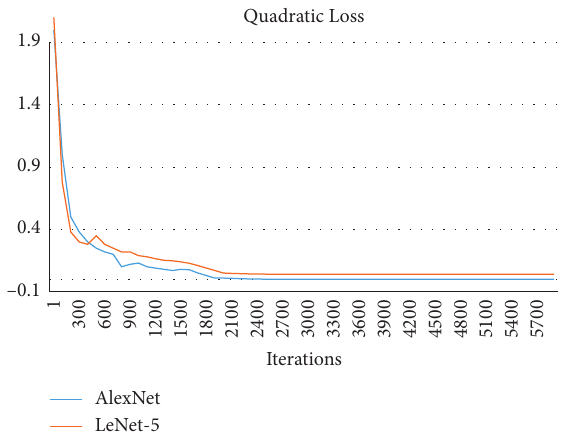
Figure 5: Performance comparison of both LeNet-5- and AlexNet- based models in Quadratic Loss at every